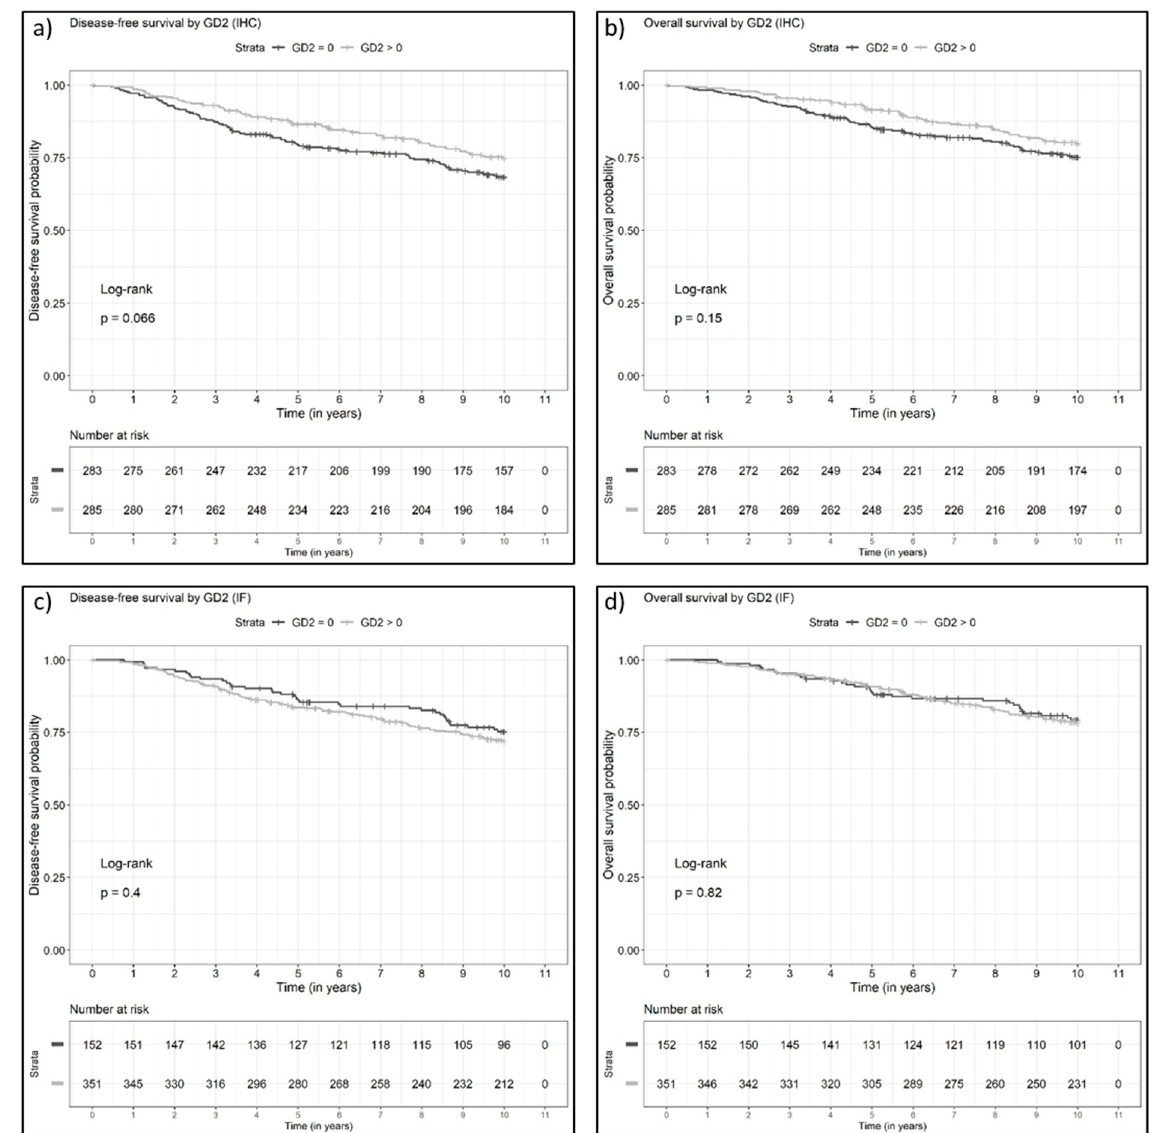
Figure 3. ( a , b ) Kaplan–Meier curves for ( a ) disease-free survival and ( b ) overall survival (OS) in patients with negative (0) and positive (>0) GD2 immunohistochemistry expression. ( c , d ) Kaplan–Meier curves for ( c ) disease-free survival and ( d ) overall survival in patients with negative (0) and positive (>0) GD2 immunofluorescence expression. IF, immunofluores- cence; IHC, immunohistochemistry.